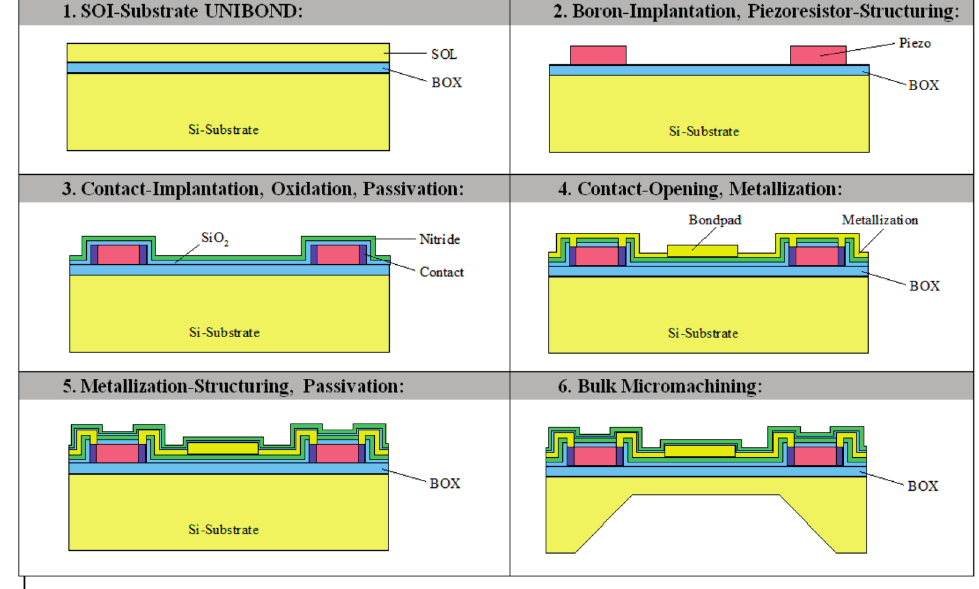
Figure 6. Process flow for sensor fabrication